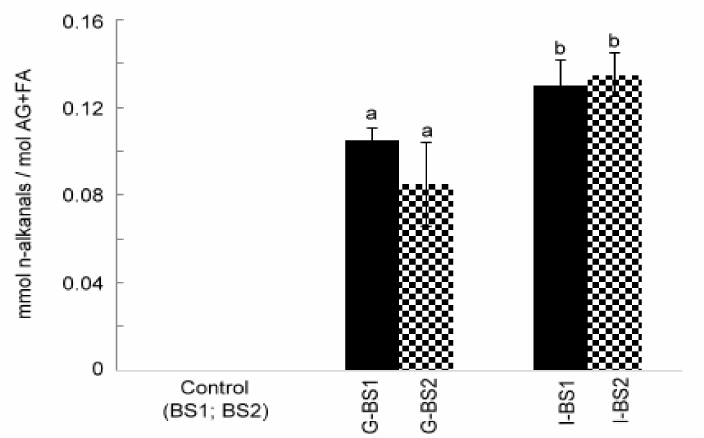
Figure 3. Concentration of n-alkanals expressed as mmol per mol of AG+FA in black seed oils 1 and 2 (BS1 and BS2) and in the digestates of these oils after gastric (G-BS1 and G-BS2) and intestinal (I-BS1 and I-BS2) in vitro digestion. Different letters indicate statistically significant differences among the samples analyzed by one-way ANOVA ( p <